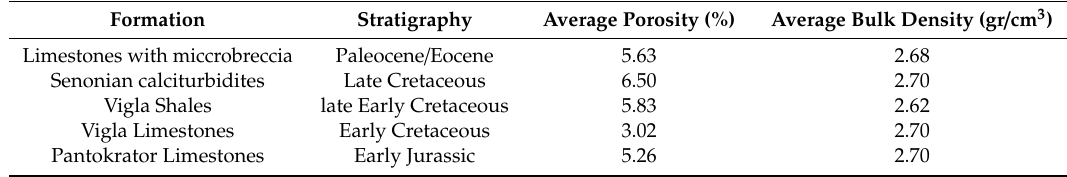
Table 2. Average porosity and bulk density values per studied formation of the Ionian